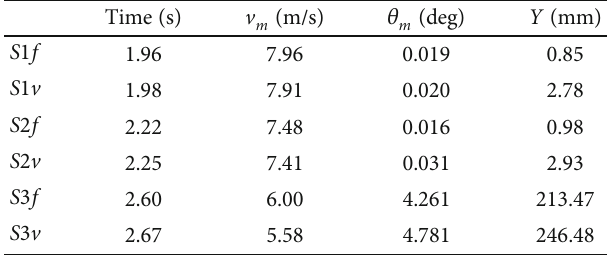
Figure 22: Missile pitch angle under two platforms. Table 3: Attitude comparison of each group of adapters under derailment under two working conditions.